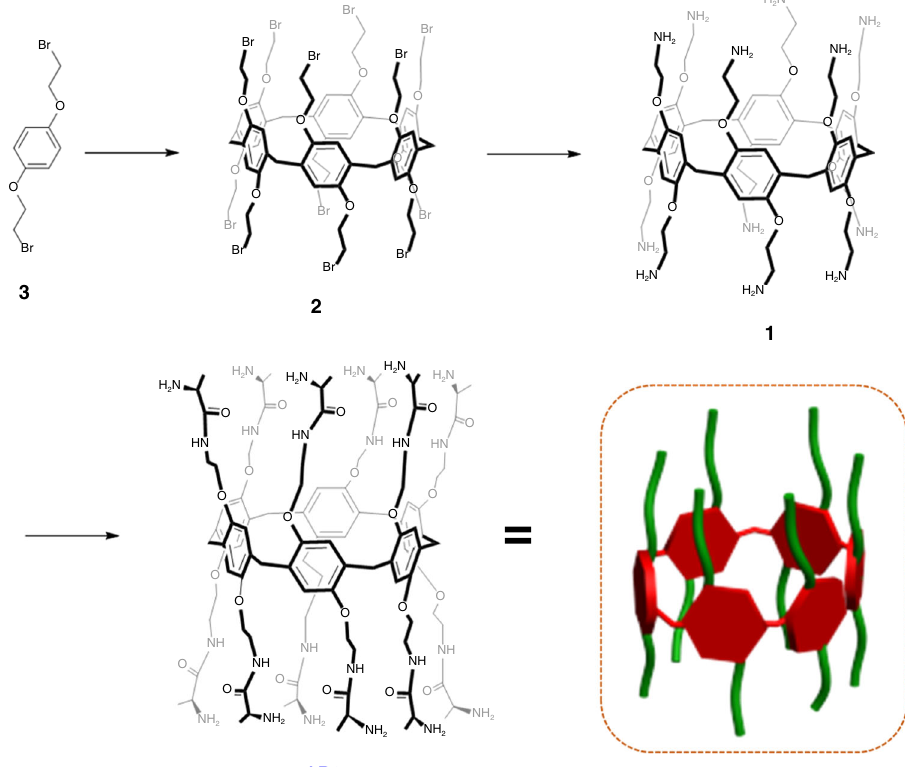
Fig. 2 Design and high ef fi cient synthesis of chiral pillar[6]arene decorated with L